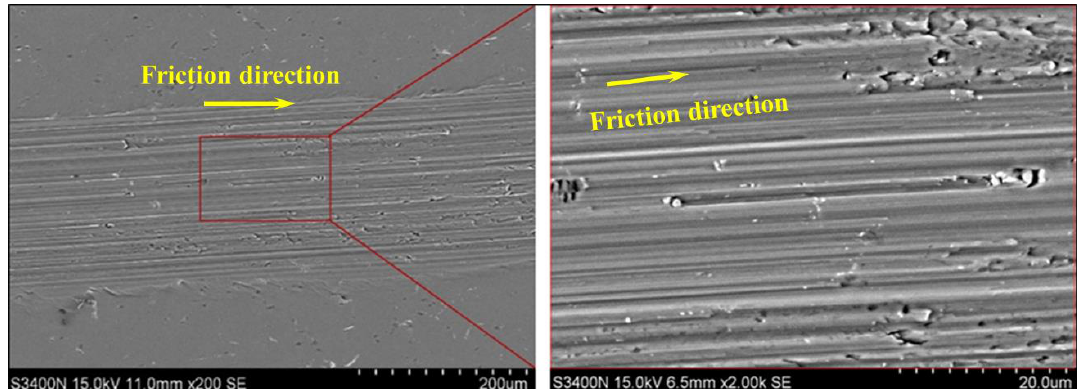
Figure 11. SEM images of the Al6061 sample after the friction test.